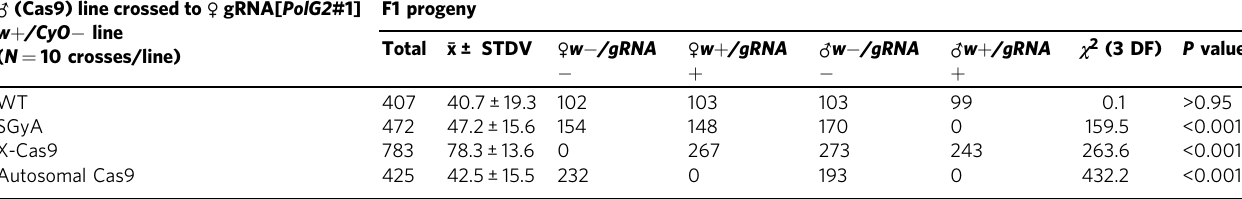
Differences in F1 survival are produced by the activity of the Y-linked Cas9 and autosomal Cas9 in transheterozygous individuals. Negative control used w[1118] males crossed to w + /CyO − females (heterozygous for gRNA#1 PolG2 ). The number of individuals observed for each of the four phenotypes from this cross is expected by random assortment ( χ 2 = 0.1, p >0.95). In SGyA experimental crosses, only transheterozygote males ( w + /CyO + ) were killed, while females (regardless of their phenotype) and males that inherited the Cas9 transgene but not the gRNA element ( w − /CyO − ) were not affected. Conversely, when females were crossed to males carrying an X-linked Cas9 transgene, only transheterozygous females were killed. The F1 progeny from autosomal Cas9 − derived crosses produced only males and females who did not inherit the gRNA element ( w − /CyO − ), whereas all transheterozygote males and females ( w − /CyO − ) were differentially killed. Signi fi cance was determined using a one-tailed χ 2 test.